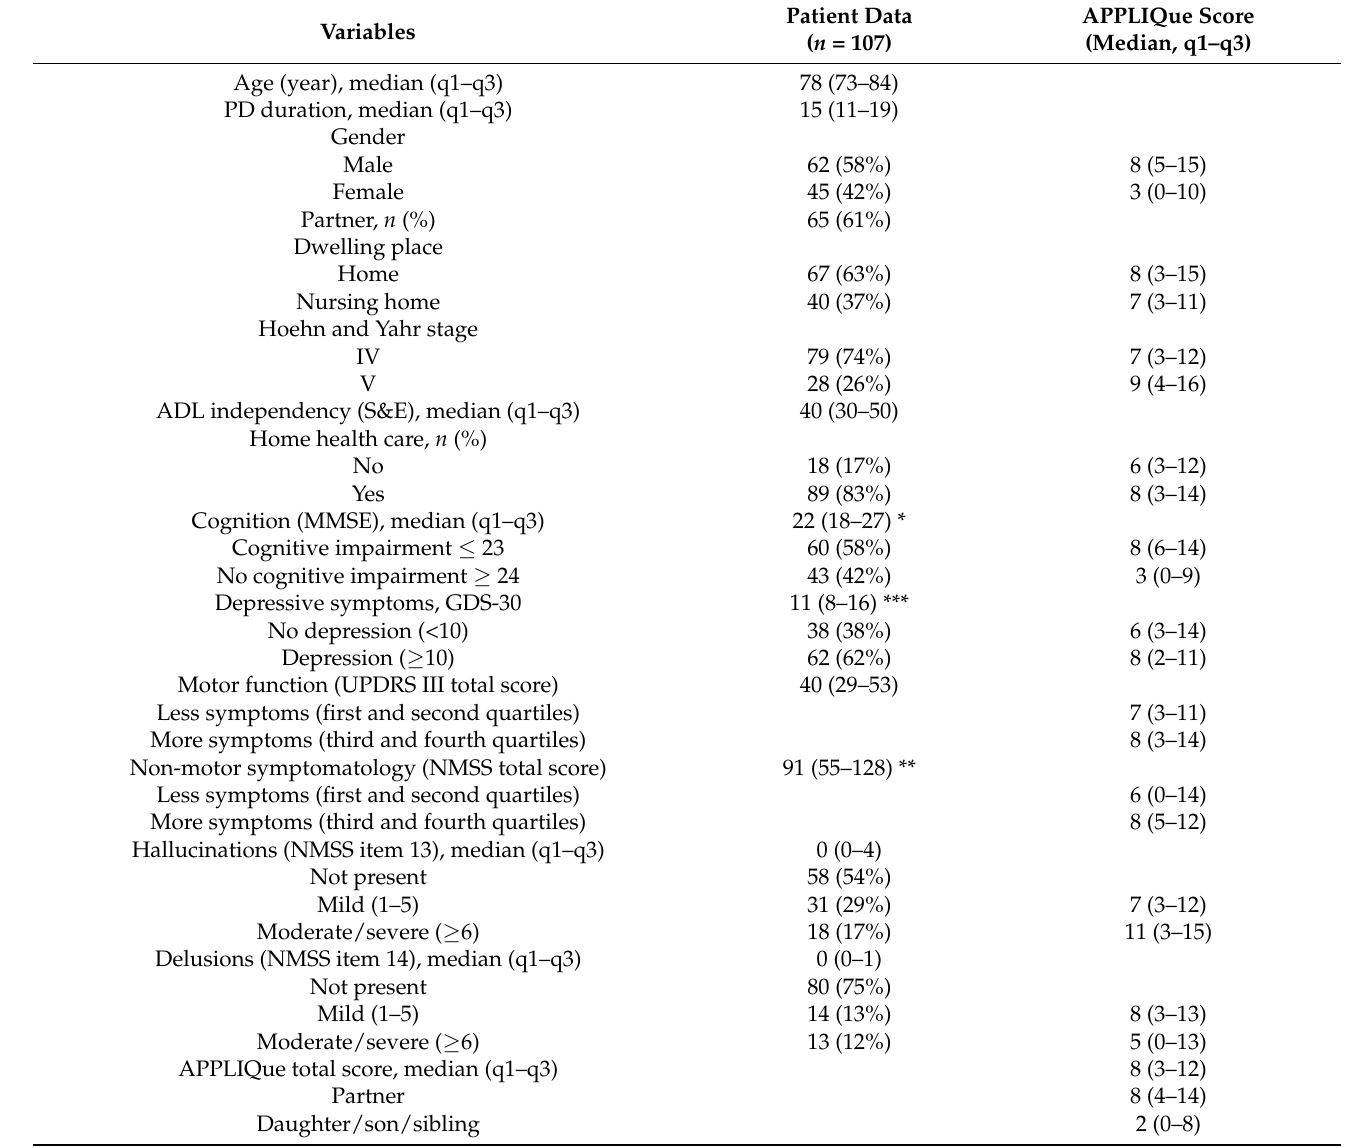
Table 1. Descriptive characteristics of patient data and in relation to informal caregiver self-reported QoL in late stage PD (APPLIQue), n =